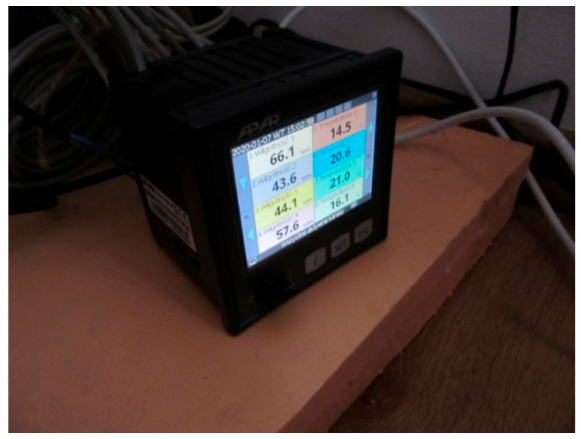
Figure 7. Measurement recording device AR207.